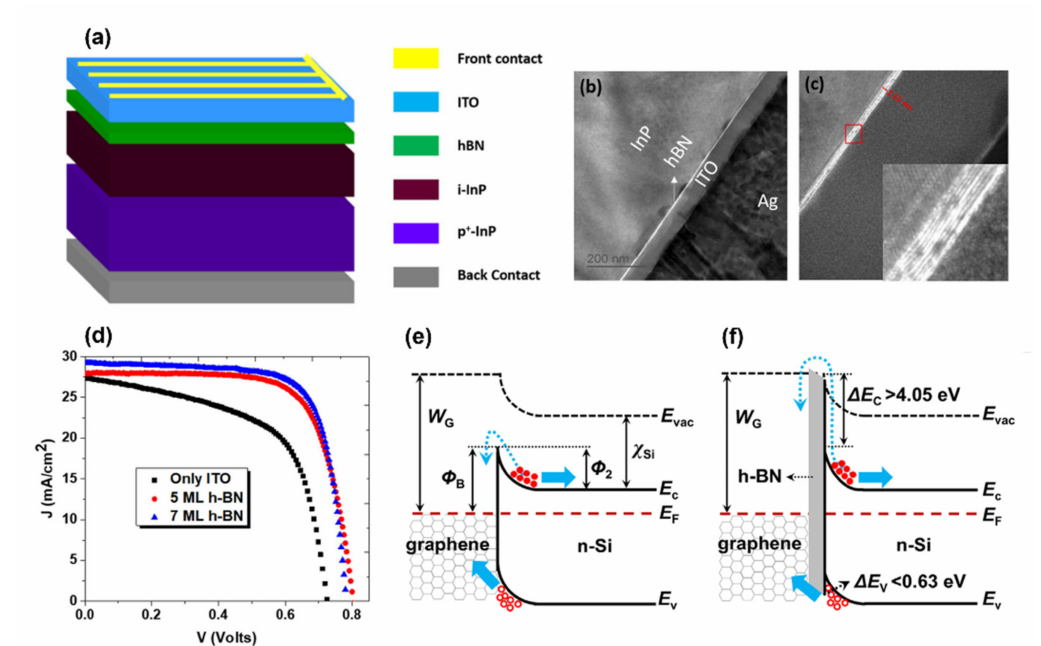
Figure 12. 3D schematic and TEM of the device structure. ( a ) A schematic showing different layers of a solar cell with 2D h-BN. ( b ) A cross-sectional TEM image of the solar cell showing different layers (scale bar: 200 nm). ( c ) A magnified TEM image showing 2.55-nm thick h-BN sandwiched between ITO and i-InP (scale bar: 20 nm). Inset shows the layered structure of h-BN. ( d ) J − V characteristics of a f the 2D h-BN-InP solar cell with and without 2D h-BN layer measured under AM 1.5 G illumination [170] (Reprinted permission from Springer Nature, copyright © 2021). Energy band diagrams of the Gr/Si Schottky junction solar cells ( e ) without and ( f ) with an h-BN electron blocking layer [173] (Reprinted with permission from Elsevier B.V, Copyright ©